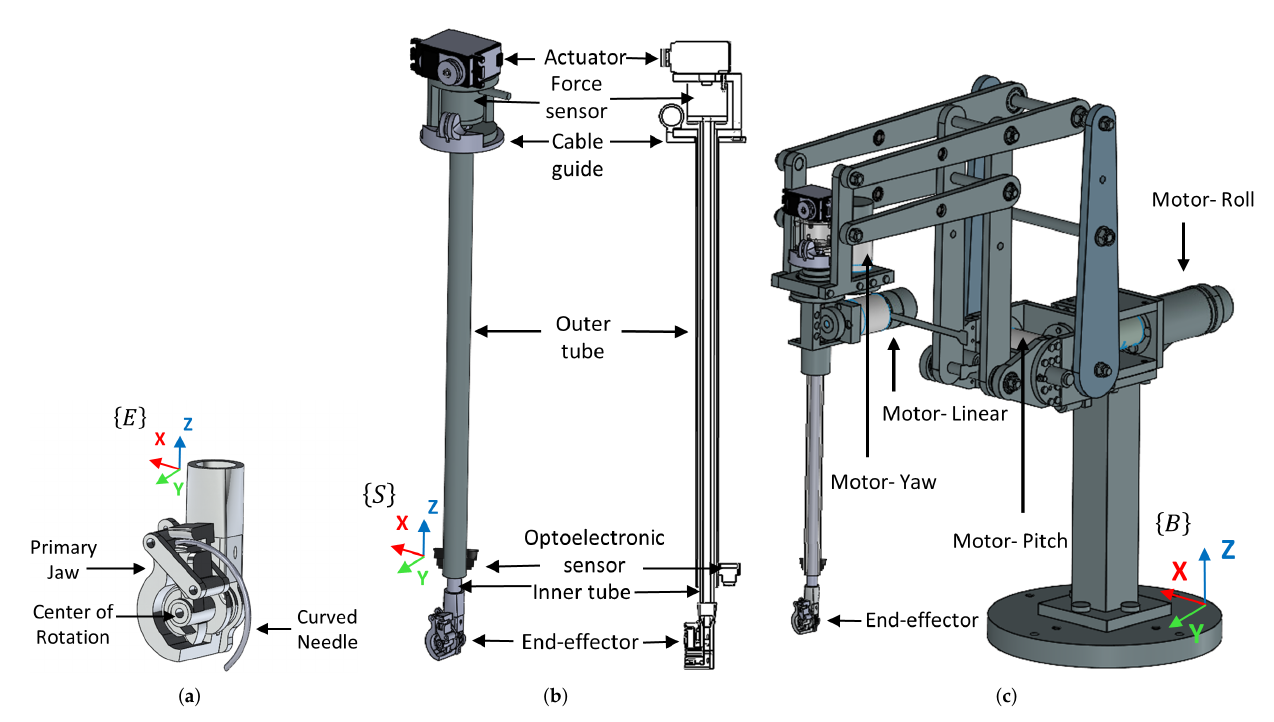
Figure 1. Proposed robotic suturing system. ( a ) end-effector; ( b ) force-sensing semi-automated needle driver instrument; ( c ) MIS robotic